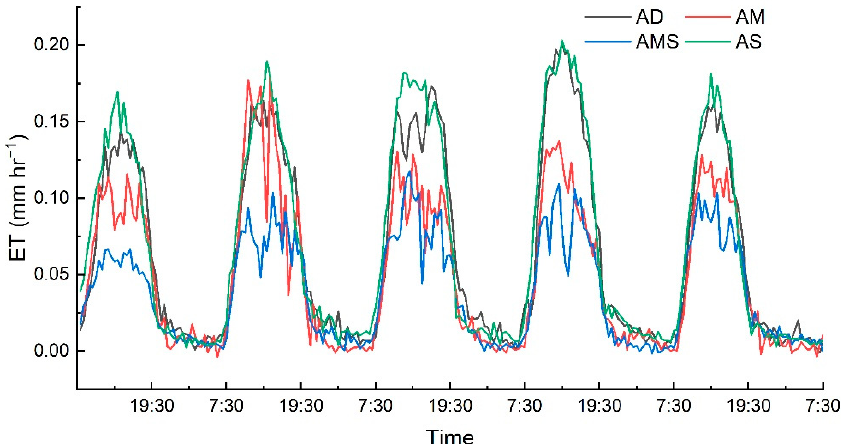
Figure 6. Diurnal variation of evapotranspiration of alpine desert (AD), alpine meadow (AM), alpine meadow steppe (AMS), and alpine steppe (AS) from May to September in 2019 in the Qinghai Lake Basin.